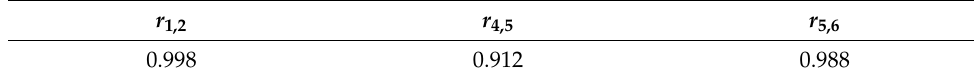
Table 9. Correlation indices between Case 1 buckling